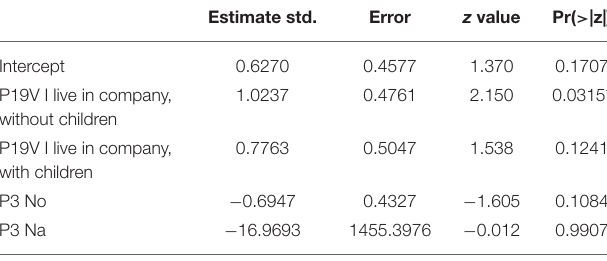
TABLE 3 | Optimized logistic regression n.2. Estimate std.